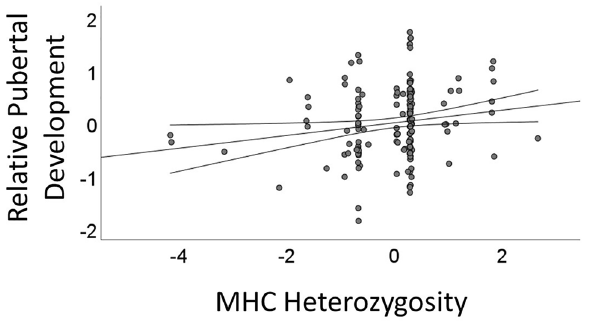
Figure 1. Partial regression plot. Best-fit line from least-square regression and 95% confidence interval for the relationship between z-transformed MHC heterozygosity residual values and self-reported relative pubertal development residual values in young